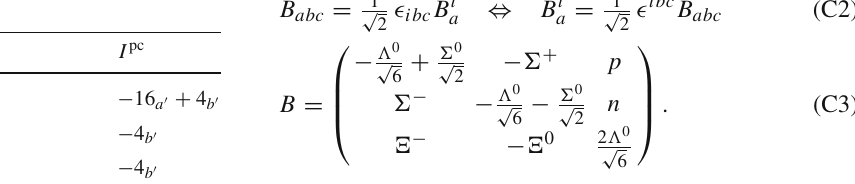
Table 16 (cid:2) C = 0 values of the weak transition matrix element I pc = (cid:4) B | H pc ( 8 ) | B (cid:5) . The suffix labelling ( a (cid:2) ) and ( b (cid:2) ) is explained in f i